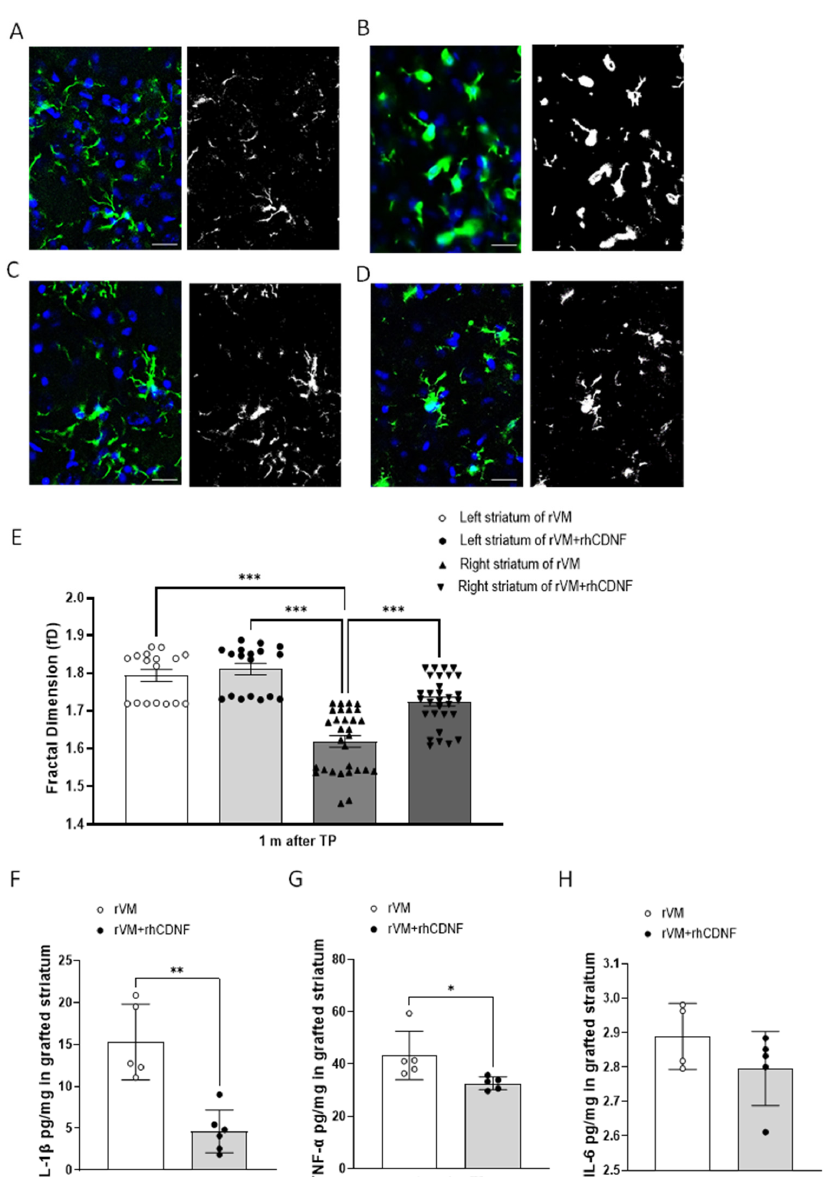
Figure 8. CDNF affects complexity analysis of Iba1 − positive cell morphologies and suppresses the production of proinflammatory cytokines in the grafted striatum at one month after transplantation. ( A – D ) Fractal analysis of microglia/macrophages in Iba1-stained tissue. Original photomicrographs were subjected to a series of uniform ImageJ plugin protocols prior to conversion to binary images. Binary images were subsequently analyzed by using FracLac of ImageJ, which quantifies single cell complexity (fractal dimension, fD). Representative images of morphological changes in Iba1 − staining cells within the left striatum in rVM − grafted rats ( A ), the right striatum in rVM-grafted rats ( B ), the left striatum in rVM + rhCDNF − grafted rats ( C ), and the right striatum in rVM + rhCDNF − grafted rats ( D ). Scale bar = 20 µ m. ( E ) Summary data and statistical analysis of fractal dimension at one month after transplantation ( n = 17 − 30, one-way ANOVA p < 0.001, *** p < 0.001 compared to the right striatum in rVM-grafted rats, Tukey’s post hoc test). ( F ) IL-1 β concentrations in the grafted striatum were measured by ELISA. ( G ) TNF − α concentrations in the grafted striatum were measured by ELISA. ( H ) IL − 6 concentrations in the grafted striatum were measured by ELISA. * p < 0.05, ** p < 0.01 indicates comparison with rVM group with Student’s t -test. The data represent mean ±